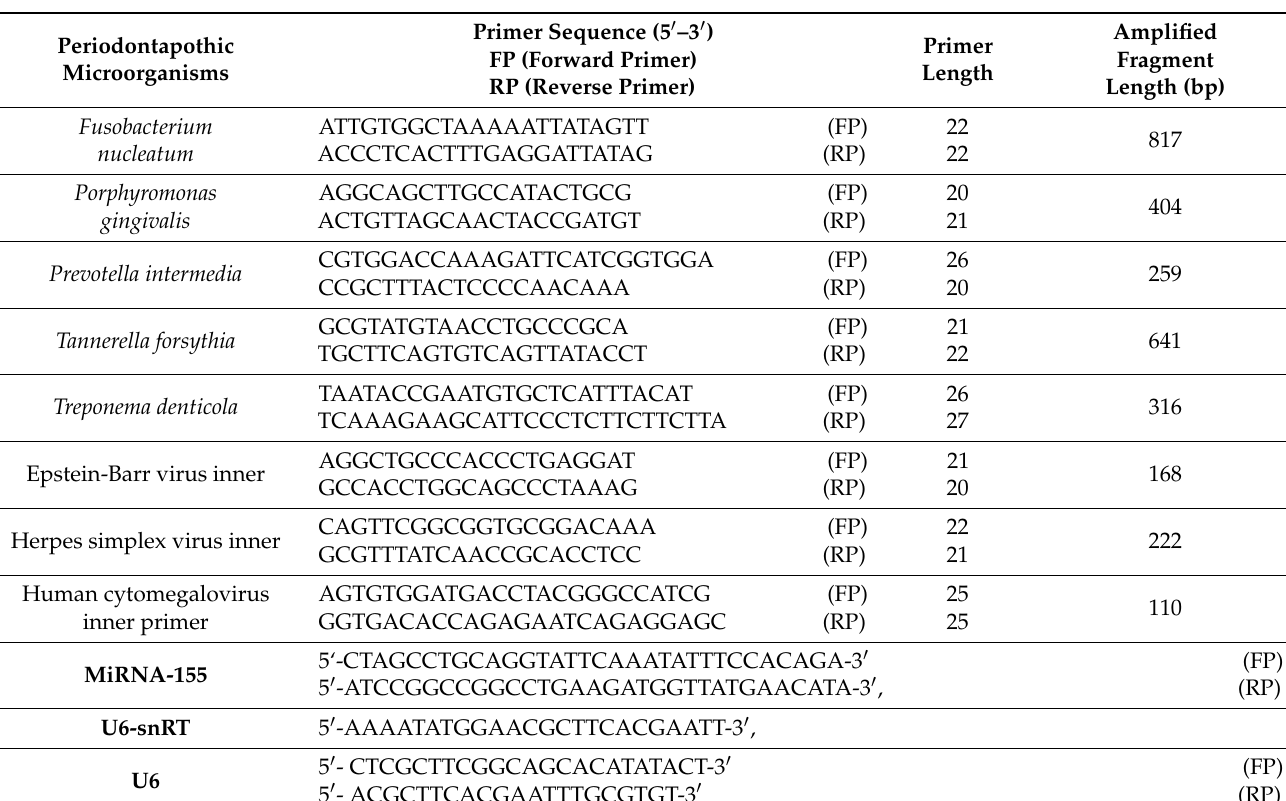
Table 1. Primer sequences of Putative Periodontopathic microorganisms bacteria ( Pg, Tf, Td, Pi, and Fn ), viruses (HSV, EBV, and HCMV), and MIR155.